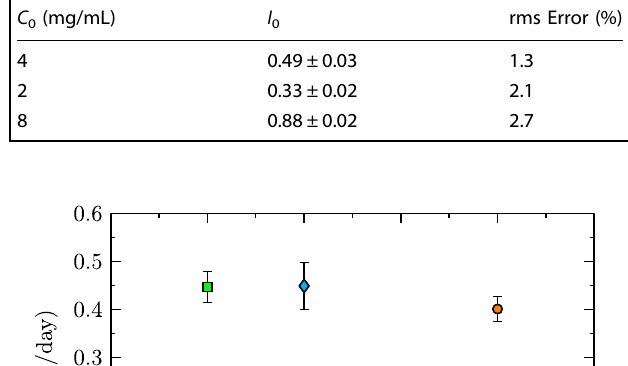
fi tting to a fi brillization model